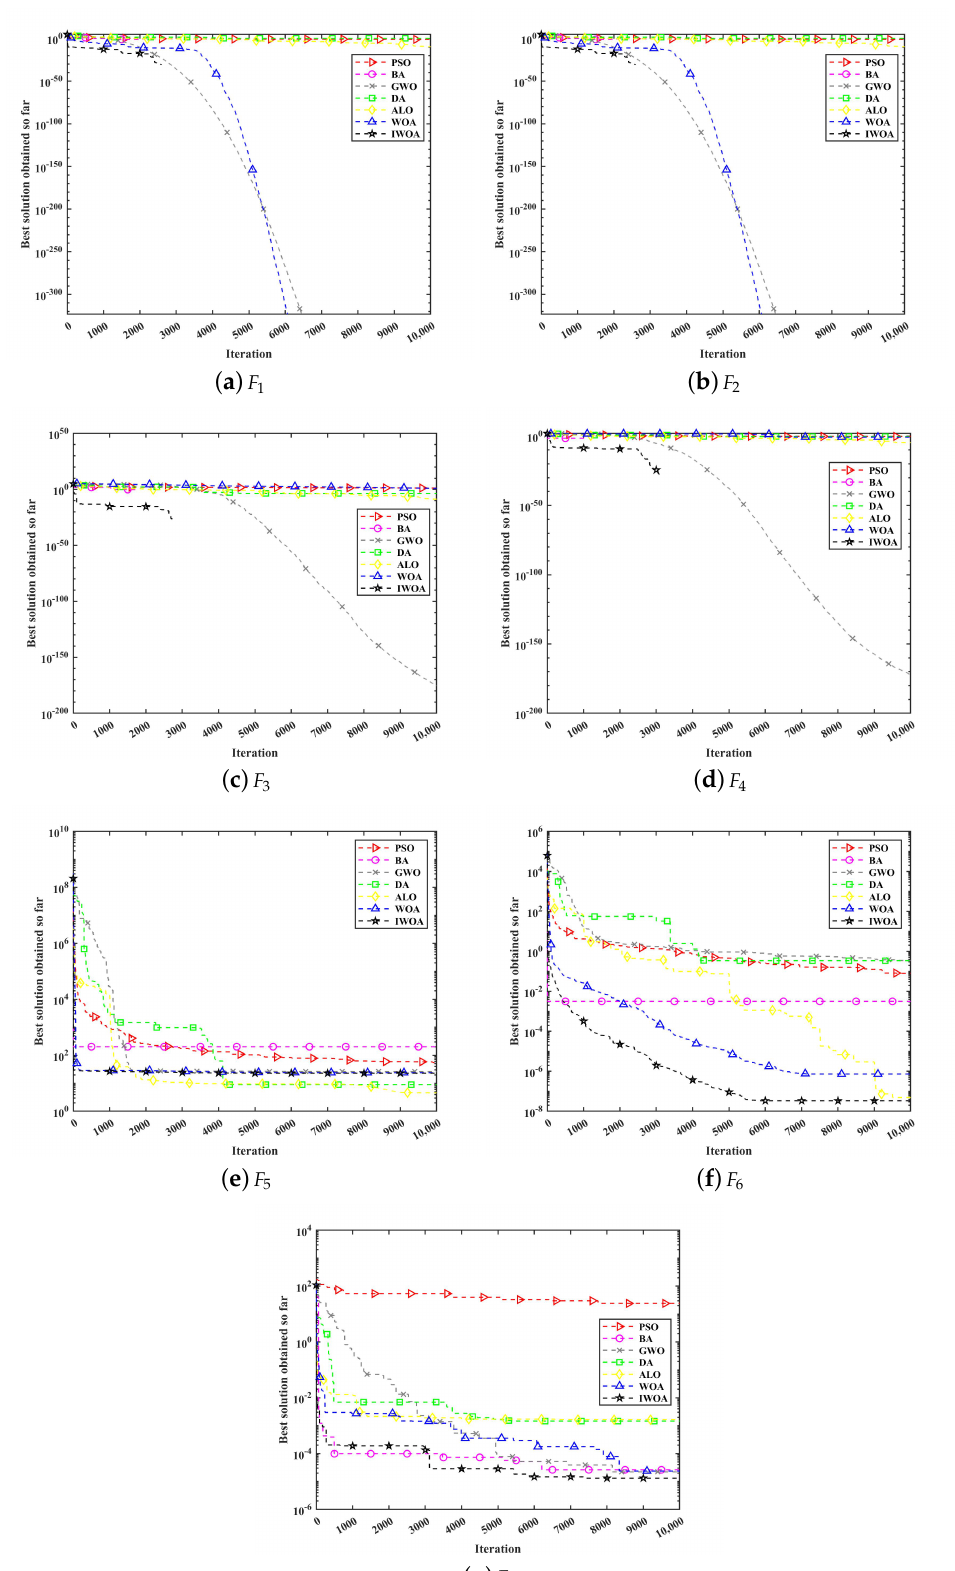
Figure 7. Different algorithms solve F 1 ∼ F 7 uni-modal test functions, and the solution value changes with the number of